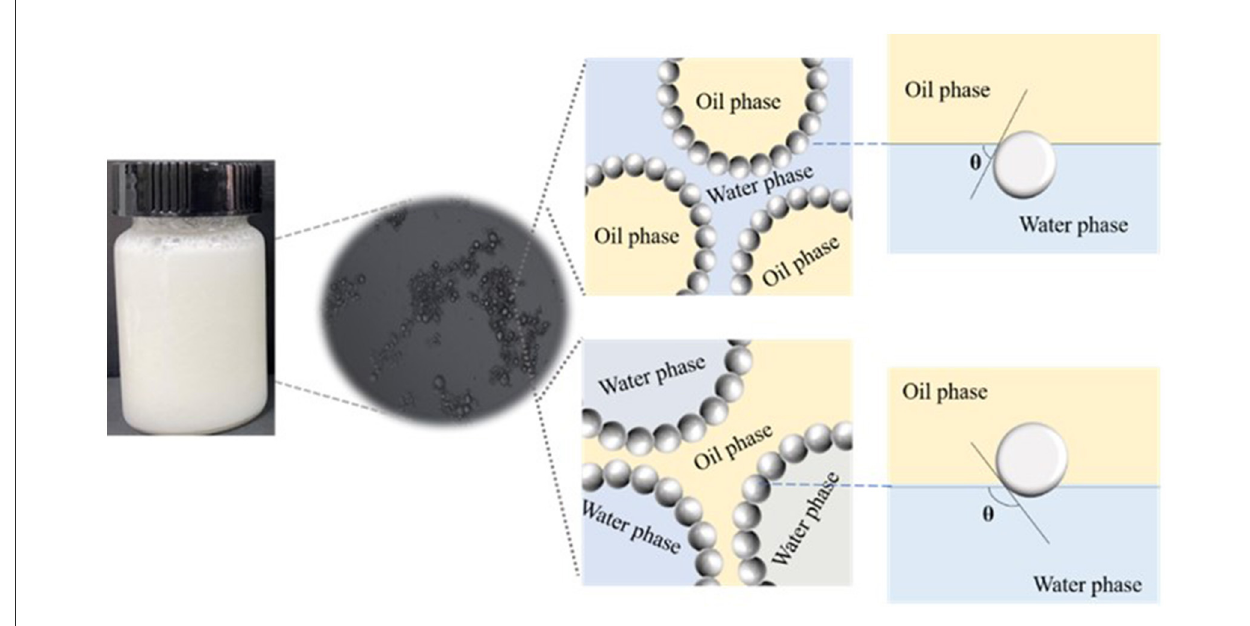
FIGURE3 Typical structure of Pickering emulsion.